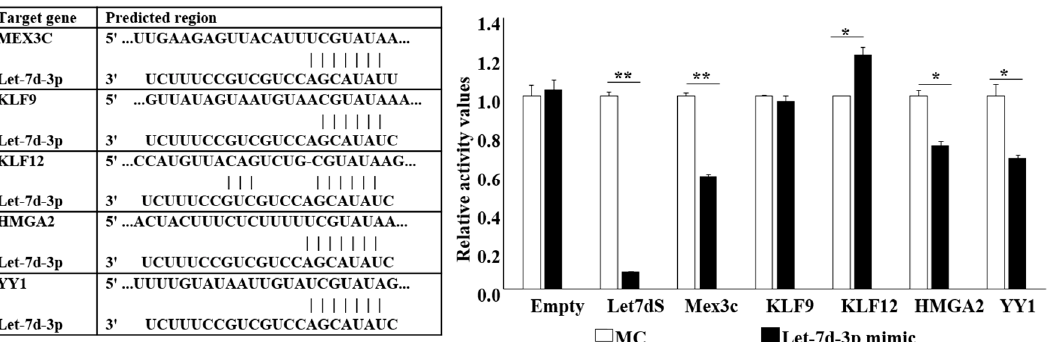
Figure 4. Validation of the gene targets of Let-7d-3p using luciferase assay. The predicted binding site of the target genes are shown in the Table. Let-7d-3p mimic reduced the luciferase activity of the Mex3c. HMGA2, and YY1 3’UTR constructs. Let-7d sensor (Let-7dS) served as a positive control. Data are presented as Mean ± SD with Student’s t-test, * p < 0.05, ** p < 0.01.